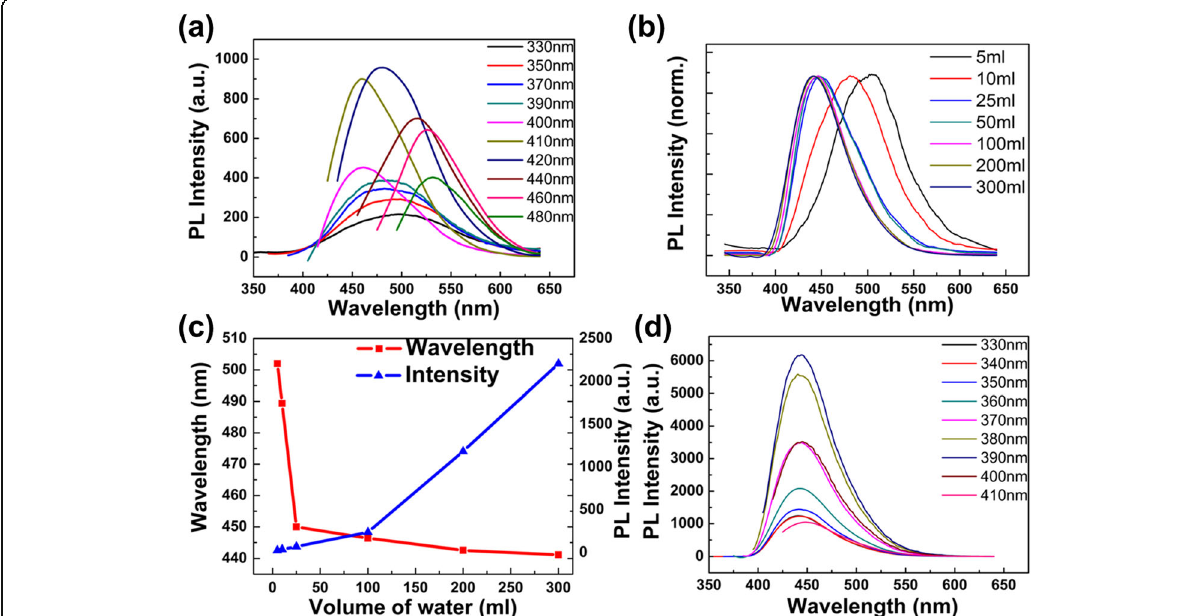
Fig. 3 PL spectra of CDs in different volume of deionized water. a PL spectra of 1 ml as-prepared CDs with 5 ml deionized water (pH 10.41). b Normalized fluorescence emission spectra of CDs in different volume of water with the excitation wavelength of 330 nm. c The maximum PL intensity and the emission peak as the function of different volume of added water. d Emission spectra of diluting 1 ml as-prepared CDs solution with 300 ml deionized